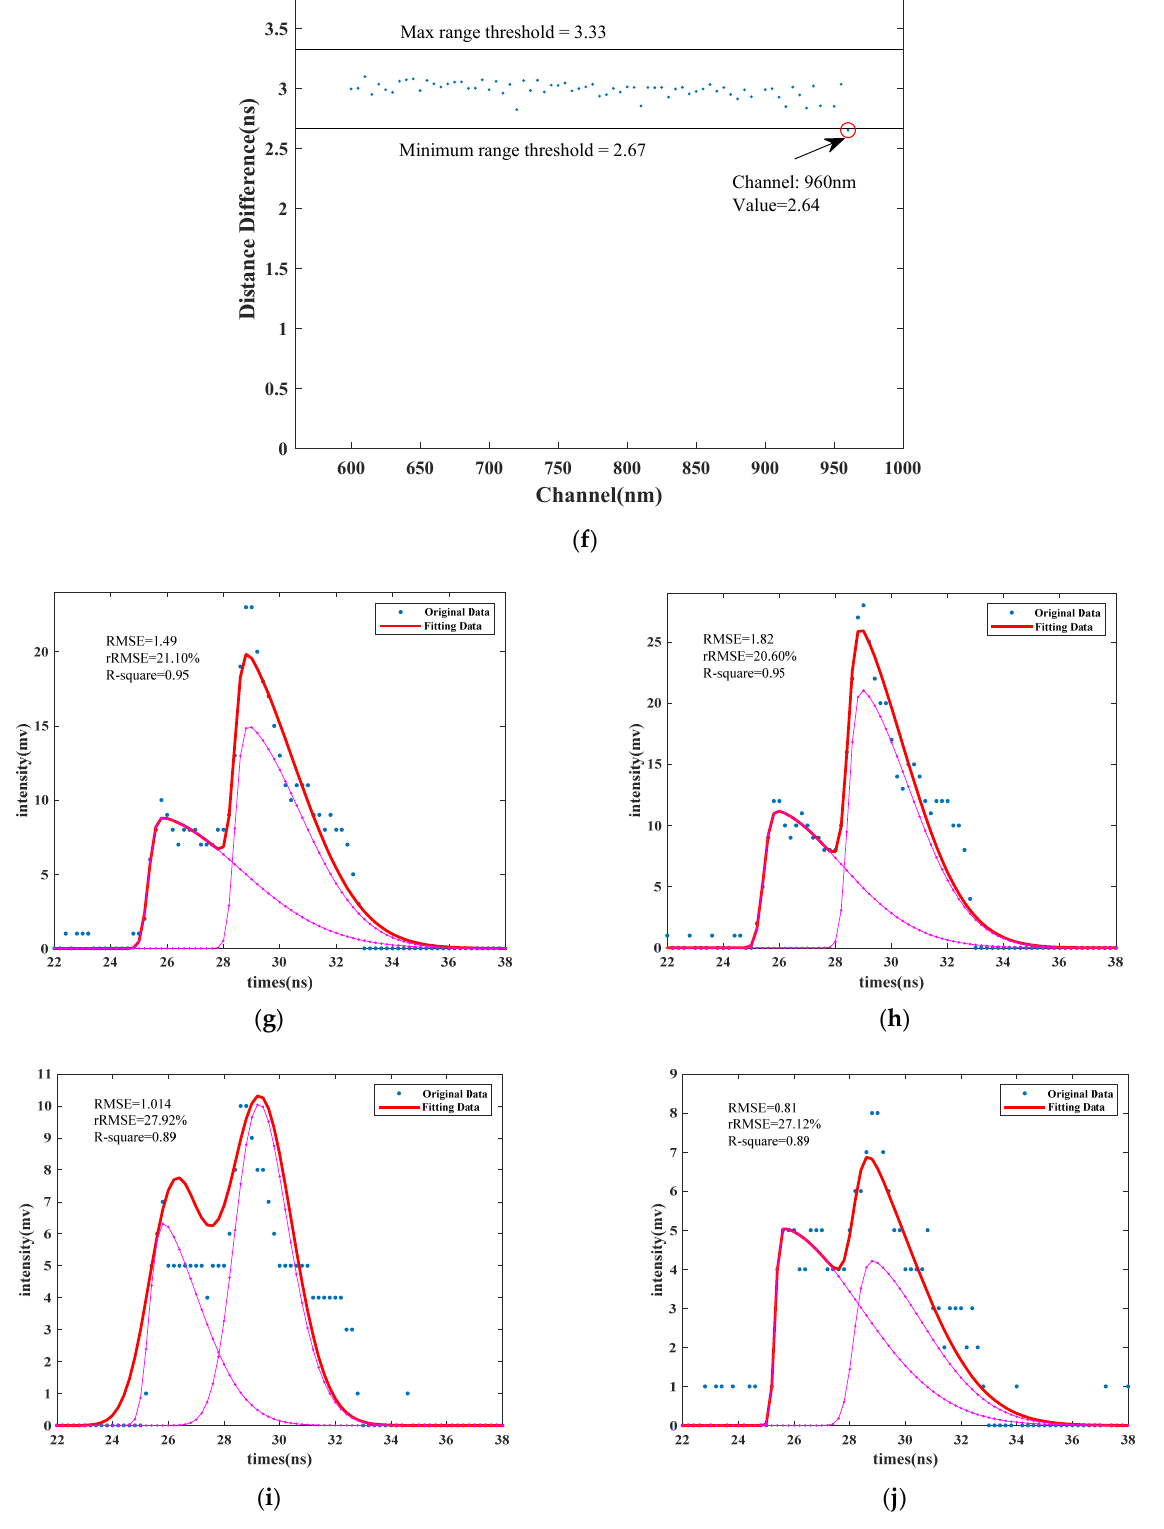
Figure 7. Comparison of SCWD and MCMCD. ( a , f ) Distance difference of all channels and outliers detected by thresholds. ( b – e ) Wrong waveform decomposition results by SCWD alone, and ( g – j ) improved results by MCMCD corresponding to wrong channels.